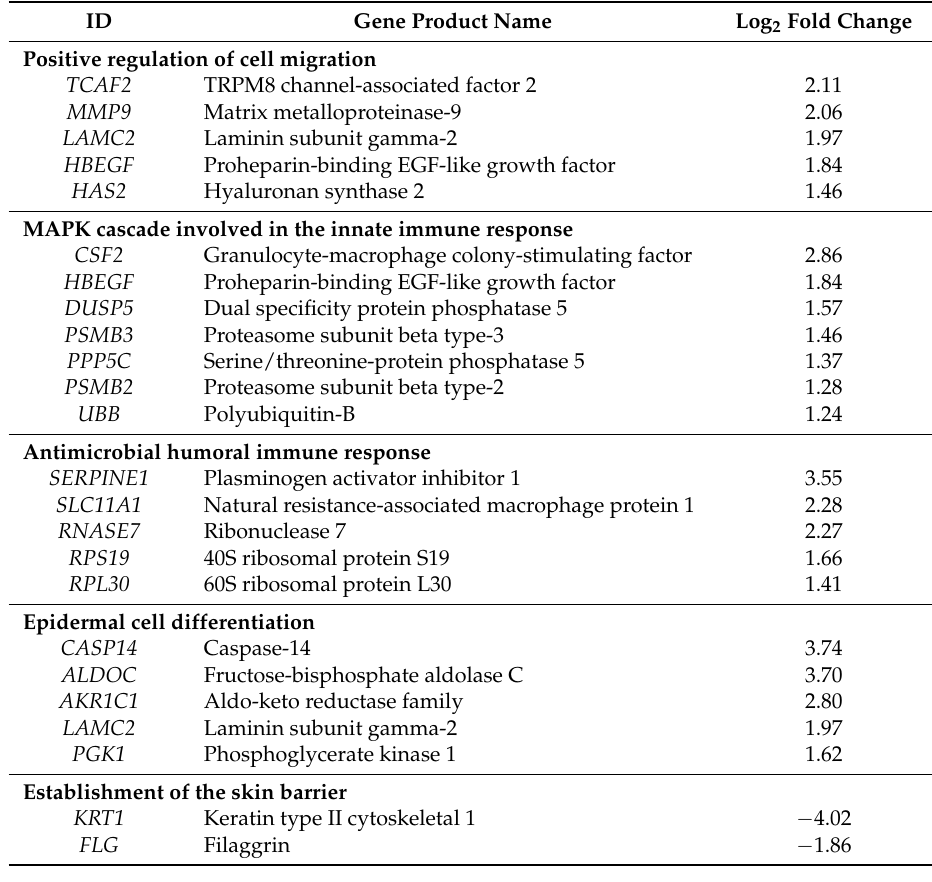
Table 4. Some functional categories and related genes important for human host